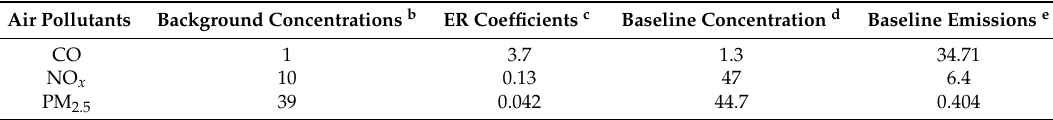
Table 2. Summary of the parameters of emissions, air concentrations and exposure-response (ER) coefficients a